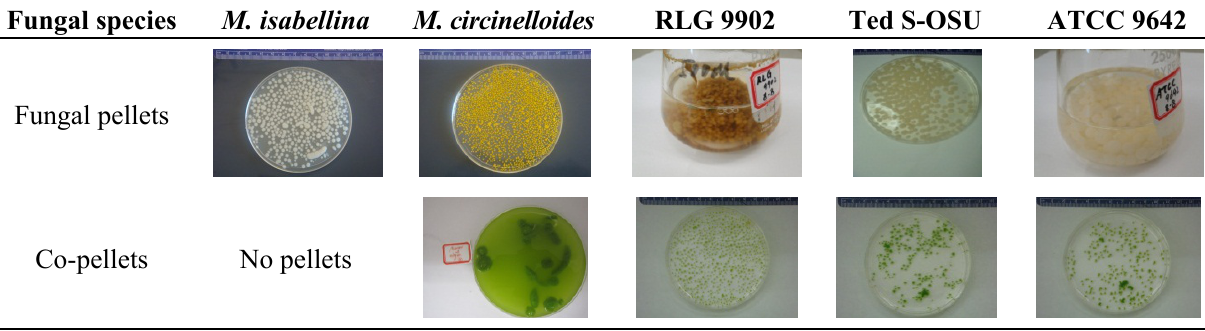
Table 1. Photos of co-pellets of fungal species and Chlorella vulgaris [63,64]. Fungal